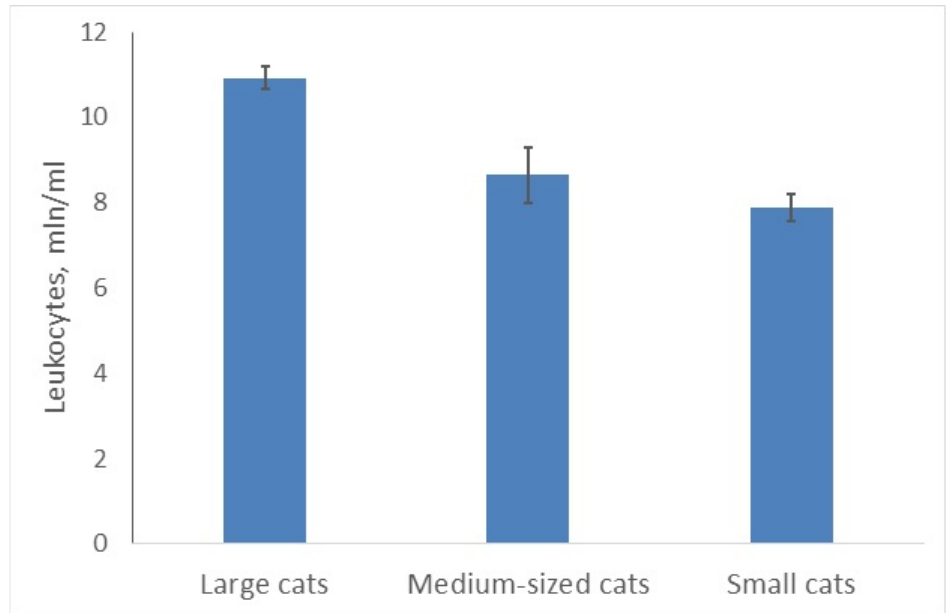
Figure 1. Average number of leukocytes in large felids is higher than in smaller ones.